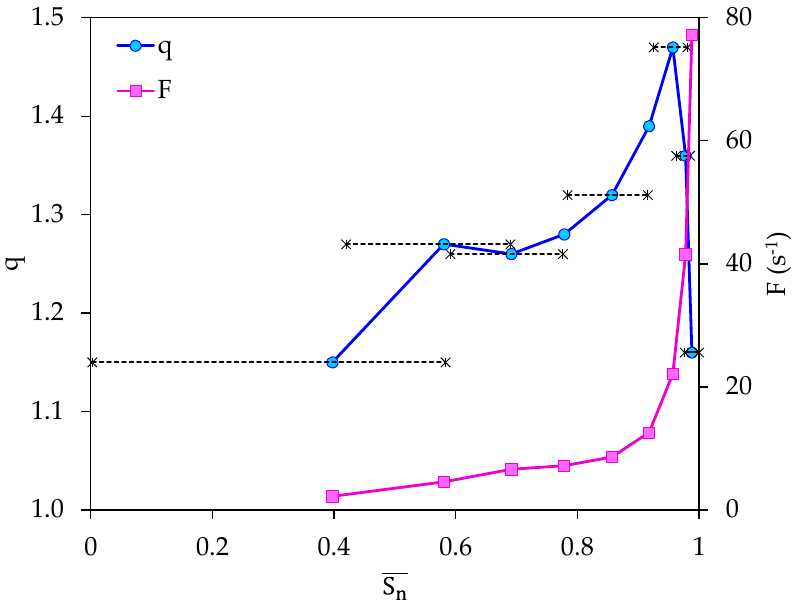
Figure 5. The variability of the entropic index q and the variability of the acoustic activity, expressed in terms of the quantity F as functions of the normalized stress S n